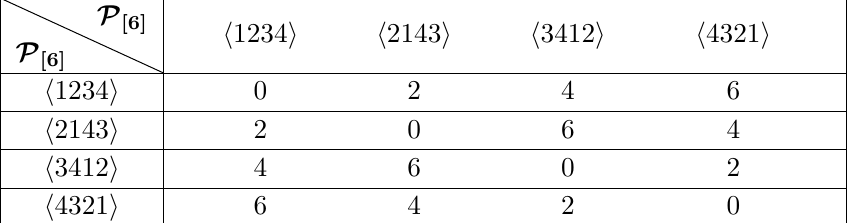
Table 6. { V M } 3 − { V M } 3 two-point correlator values. and in matrix